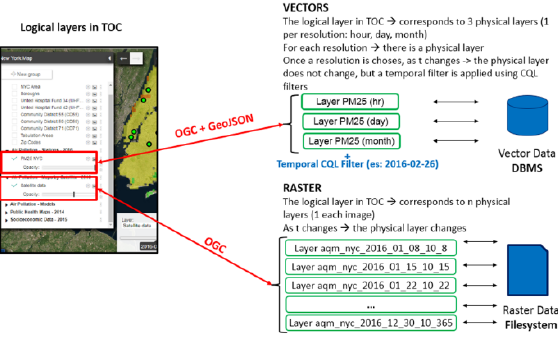
Figure 9. Temporal layers mapping to physical layers